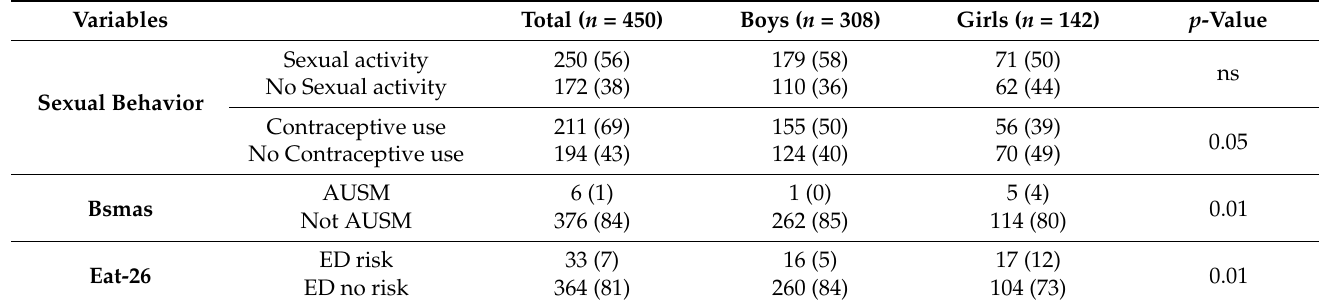
Table 2. Risk behaviors in total population and by